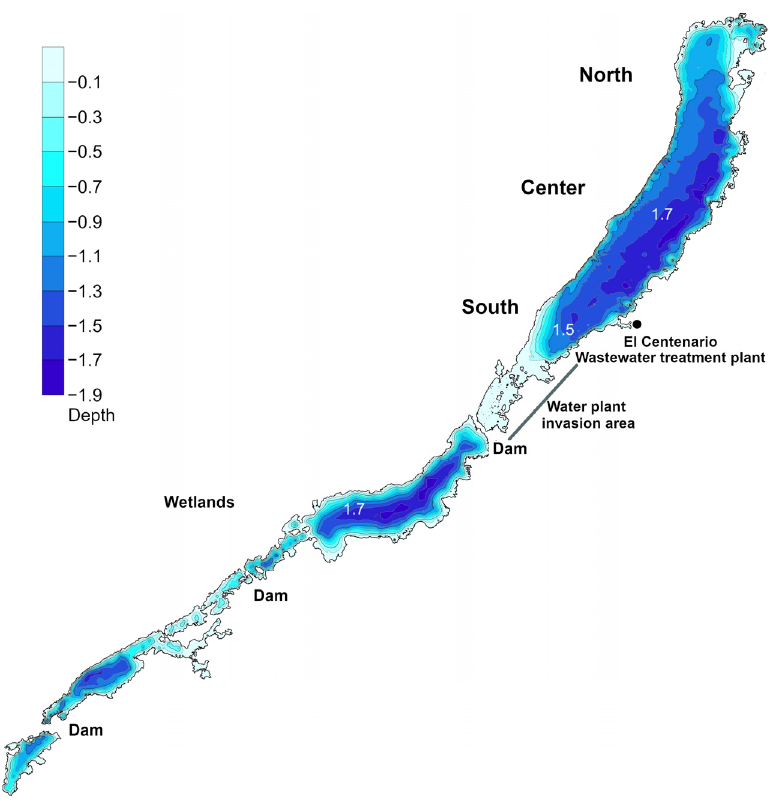
Figure 3. Bathymetric map of Lake La Sabana, isobaths show differences of 0.2 m depth. The SIMPROF test projected on the nMDS ordination plot, with a good level of stress (0.09), clearly showed five significant groups (Figure 4). The first group comprised samples from the center zone of the lake in the rainy season (Figure 4). The samples from wetland formed two well-defined and coherent groups, one corresponding with samples obtained in the rainy season and the other one comprising samples from the dry season (Figure 4). The remaining two groups included samples from the north, south and central zones of the lake, differentiated by the climatic seasons (Figure